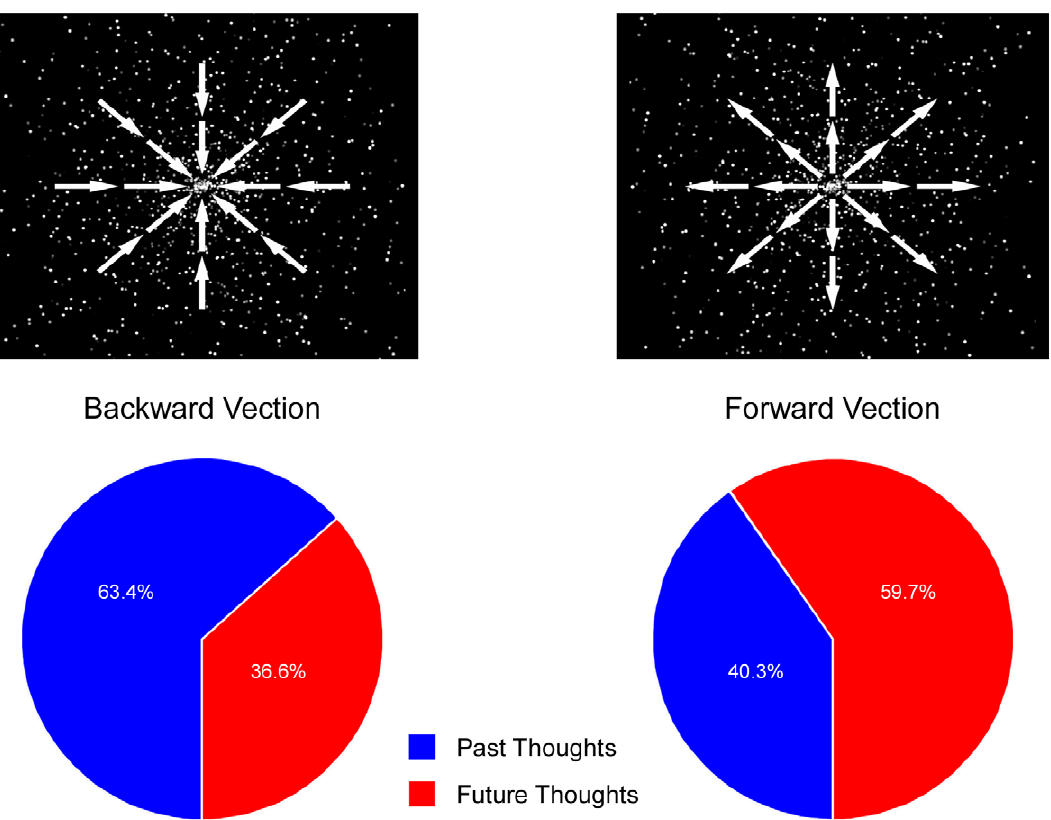
Figure 1. Vection and mental time travel. Illustrations of the direction of optical flow specified by the star-field displays (top panels) and the relative proportion of past and future day dreams reported by participants (bottom panels) as a function of vection condition (i.e., backward or forward).